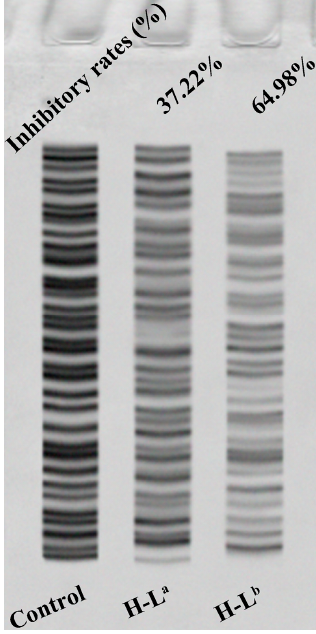
Figure 4. The inhibition of telomerase in SK-OV-3 cells by oxoisoaporphine ligands.